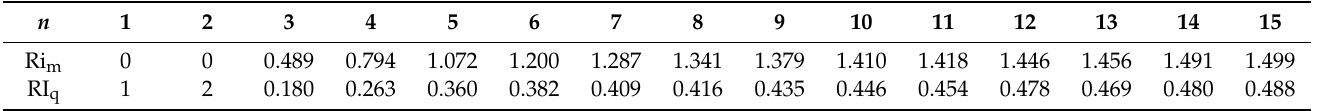
Table 5. Random indices (RI) for consistency